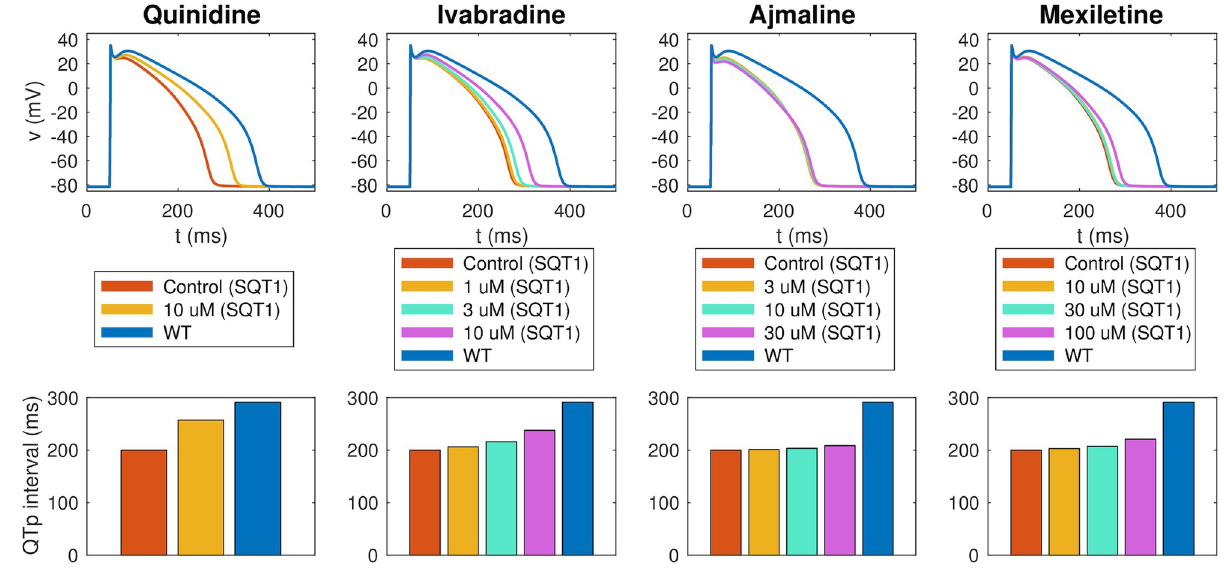
Fig 10. Estimated drug effects for adult patients with the SQT1 mutation. The figure displays the estimated drug effect of quinidine, ivabradine, ajmaline and mexiletine for adult patients with the SQT1 mutation (and a heart rate of 60 beats/min) based on the result of the inversion of hiPSC-CM data reported in Fig 8. Upper panel: Estimated drug effect on the adult ventricular action potential. Lower panel: Estimated drug effect on the QTp interval. See Fig 3 for an illustration of the definition of the QTp interval. Note that the blue lines represent the adult WT case. Data used in this figure can be found in S1